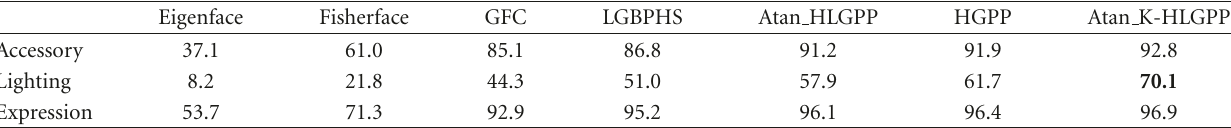
Table 4: Experiment result on CAS-PEAL-R1 database (rank-1 recognition rate).